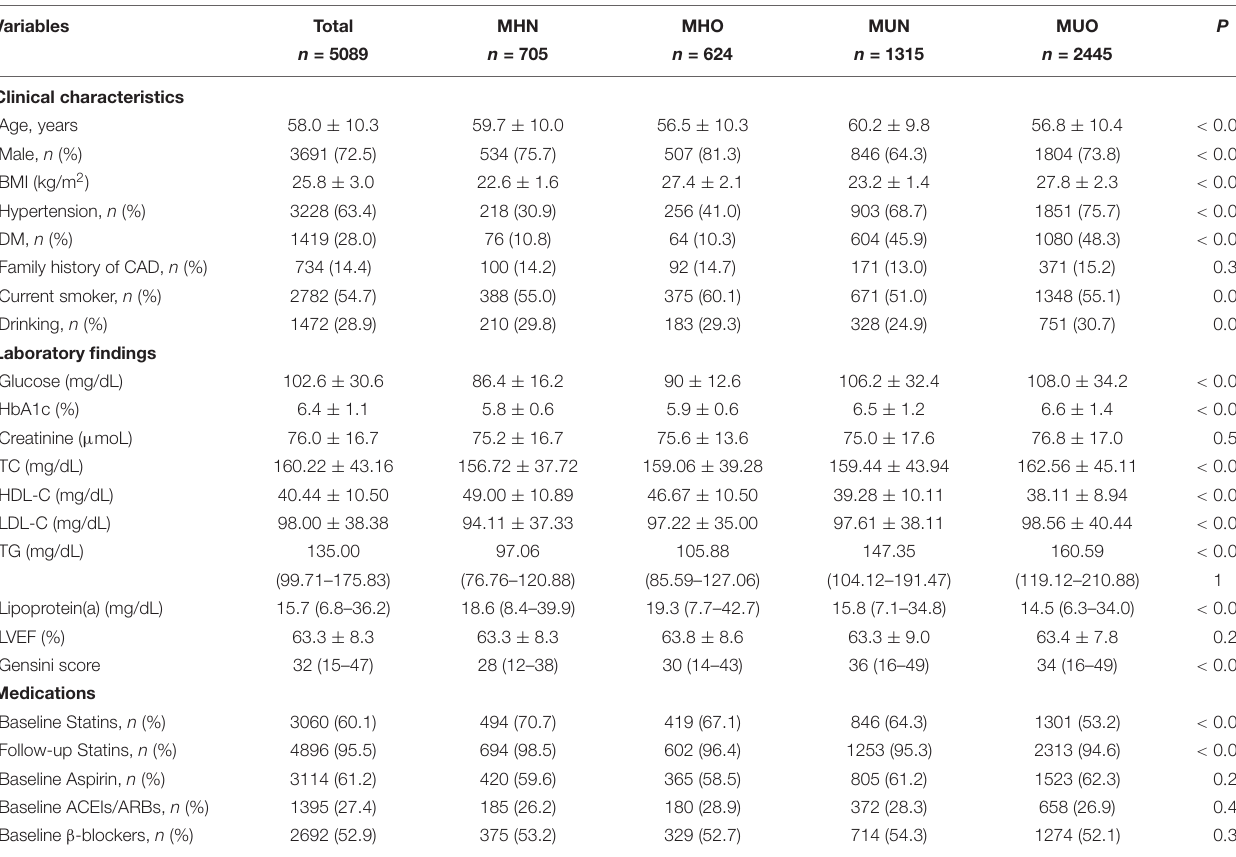
TABLE 1 | Baseline